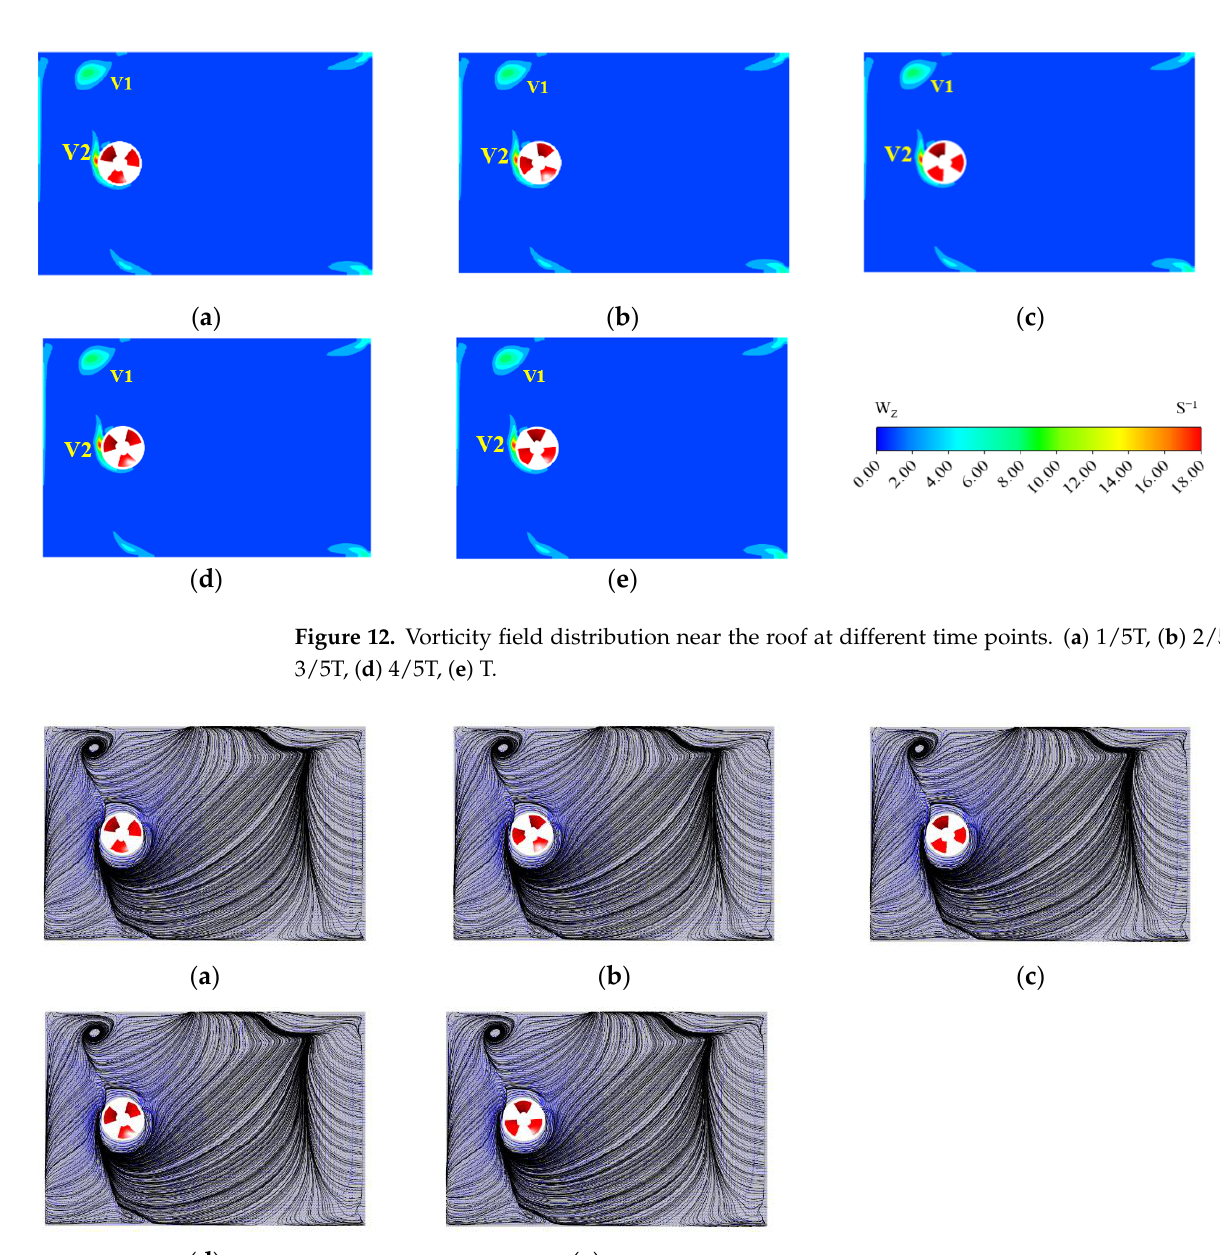
Figure 14. Vorticity intensity of V1 vortex core in 3 impeller rotation periods. To analyze the vorticity field distribution of RAV along the axial direction, five sec- tions (S1~S5) are taken along the axial direction in the closed inlet tank. As shown in Fig- ure 15, S1 is the roof’s surfac e, S3 is the center surface of the impeller, and S5 is the inlet surface of the bell mouth. As shown in Figure 16, take the vorticity field distribution of